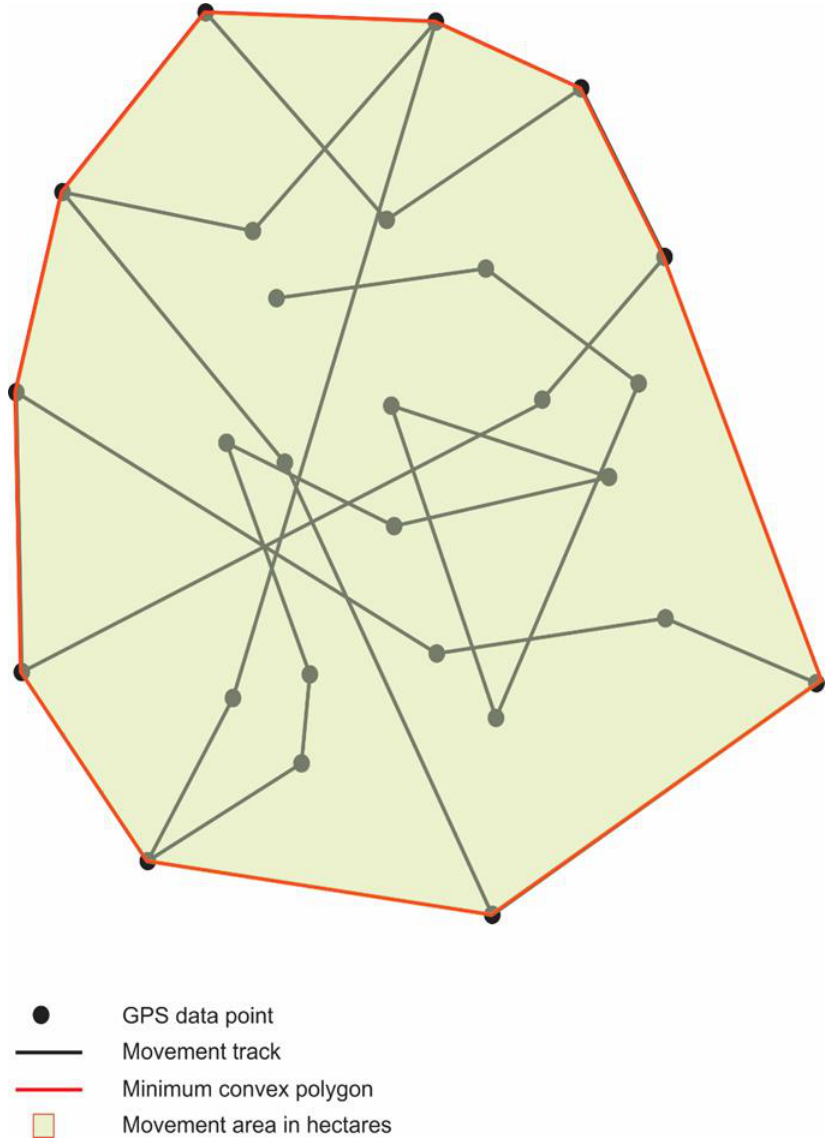
Figure 2. An illustration of a minimum convex polygon (MCP) encompassing the entire estimated potential movement area calculated from GPS data points and movement tracks This is an example of the type of polygon produced by the movement data of one GPS collared cat.